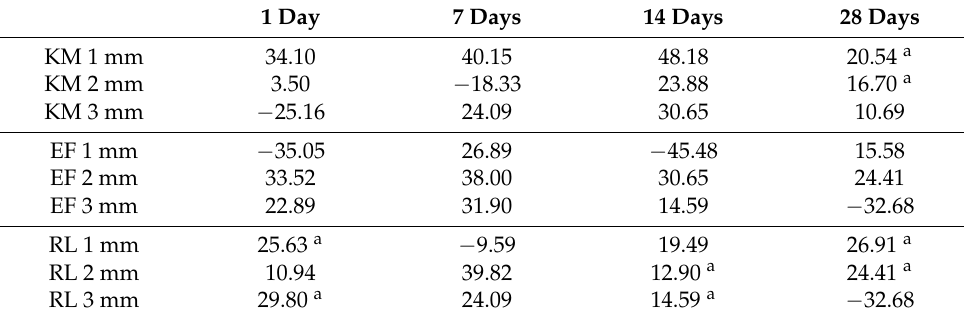
Table 3. Percentage gain in Ca/P ratio (mol), calculated from EDX results, in dentin as a function of different materials, times, and thickness compared to non-demineralized dentin.